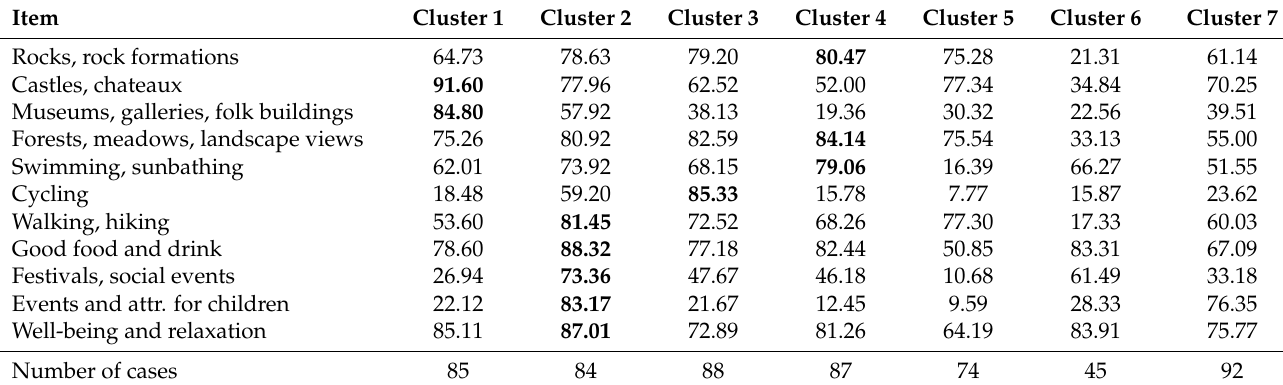
Table 1. Results of cluster analysis by K-means